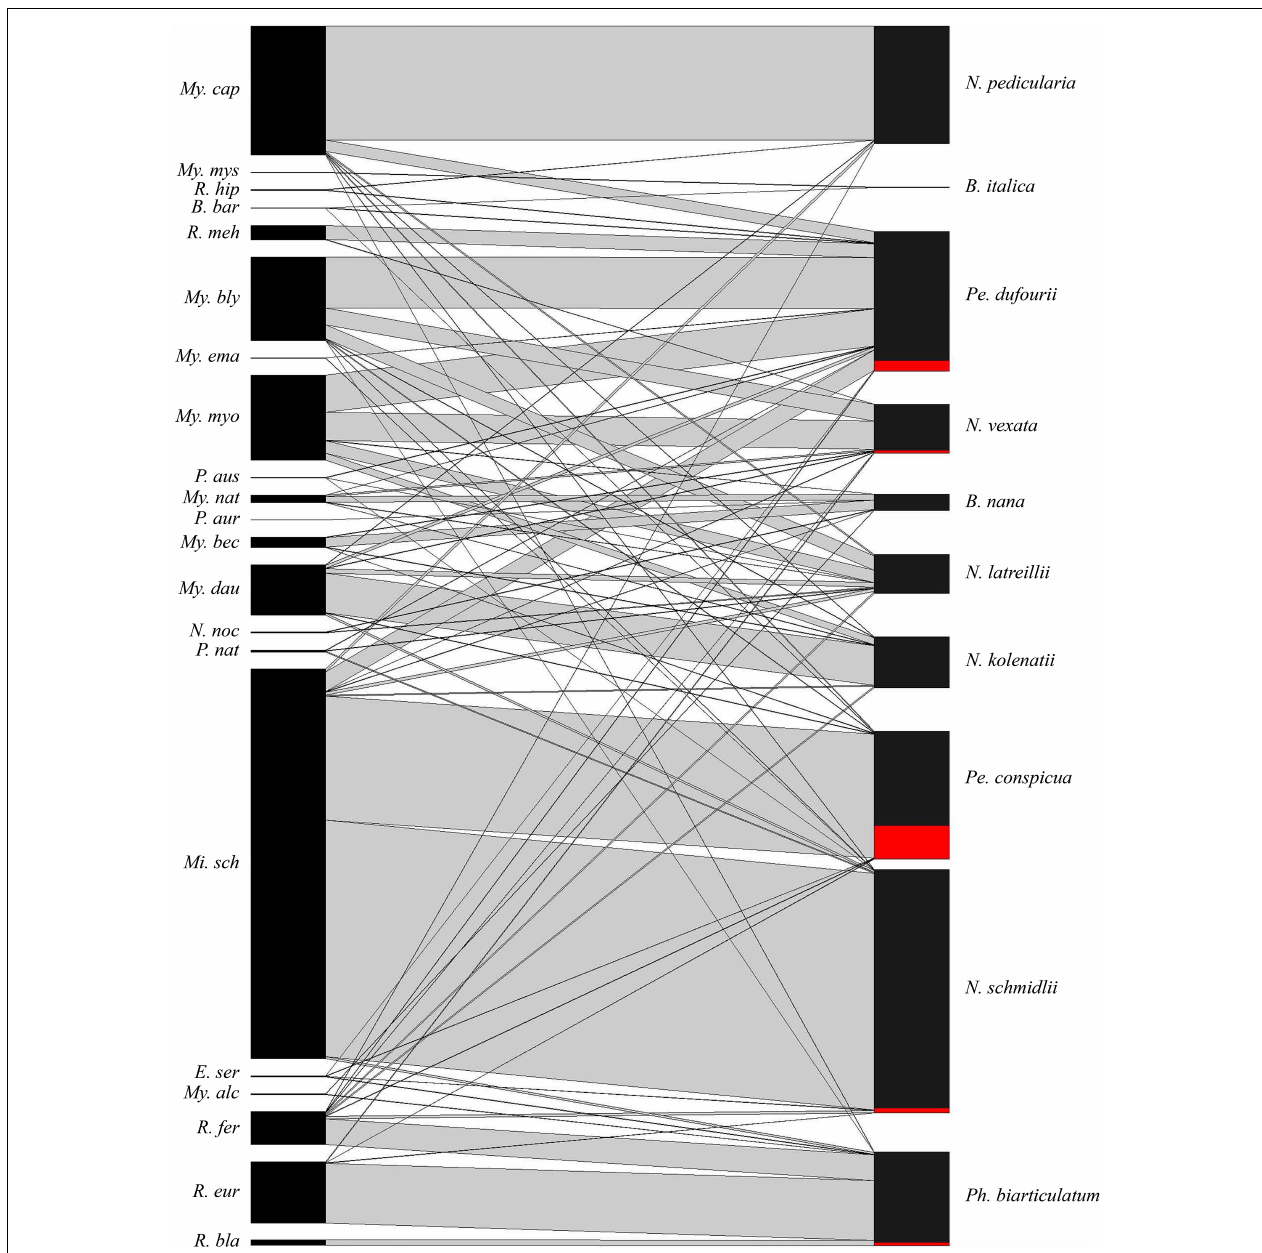
FIGURE 1 | Bat–bat fly network. Shown is the association of bat hosts (left) with their bat fly parasites (right). Bar width represents the relative abundance of a species within each network level. The parasite prevalences of bat fly species with Laboulbeniales are shown in red, for Penicillidia dufourii (8.85%), Nycteribia vexata (5.70%), Penicillidia conspicua (25.91%), Nycteribia schmidlii (2.01%), and Phthiridium biarticulatum